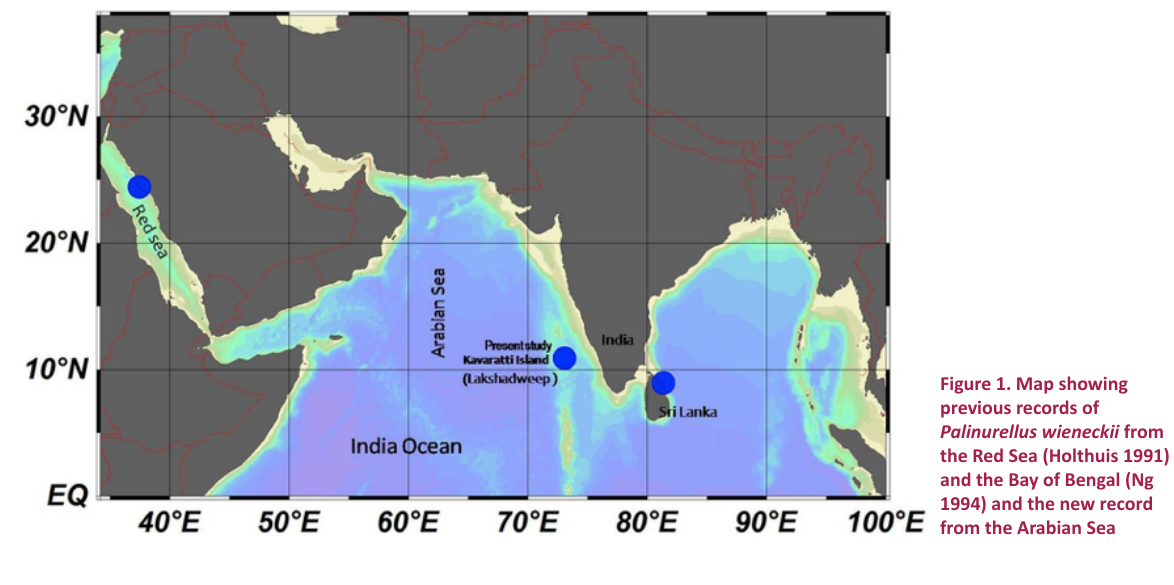
Figure 1. Map showing previous records of Palinurellus wieneckii from the Red Sea (Holthuis 1991) and the Bay of Bengal (Ng 1994) and the new record from the Arabian